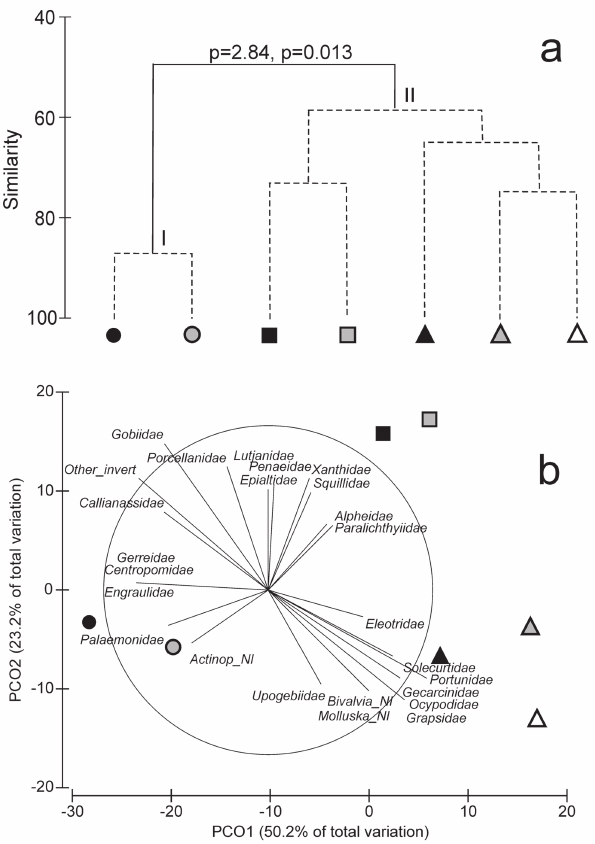
Fig. 5. a: Dendrogram showing the result of numerical classification of stomach contents. Results of